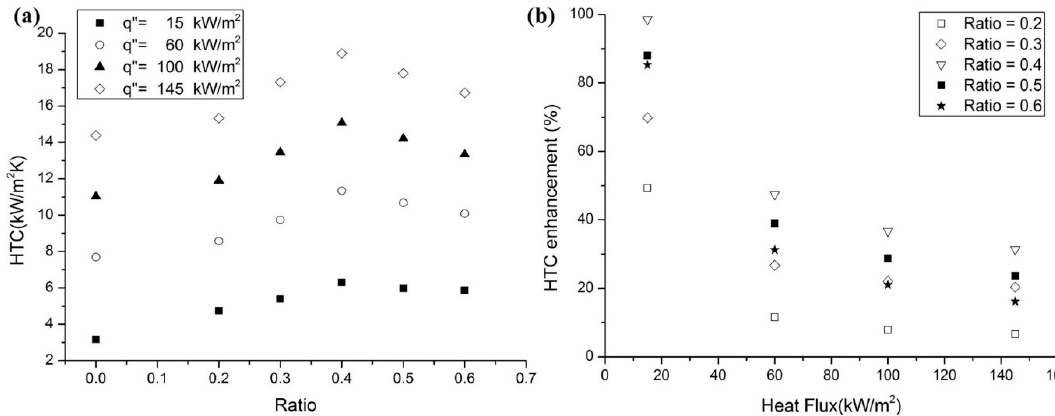
Figure 9. The effect of the pattern size on ( a ) the HTC values for the specific heat fluxes and ( b ) the enhancement percentage in HTC with respect to the heat flux.